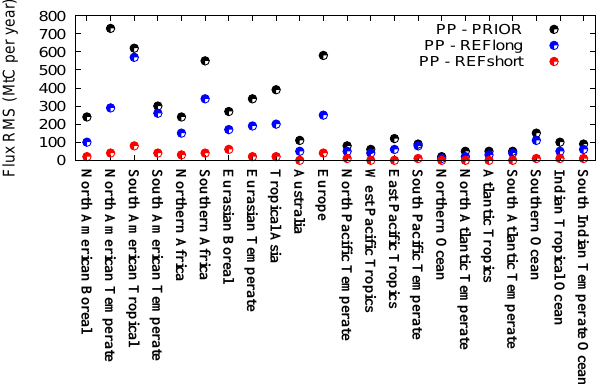
Fig. 4. RMS differences between the 1979–2010 PP inversion and the reference 1979–1992 inversion when computing the inverted weekly fluxes. The statistics are computed for the 1979–1991 pe-